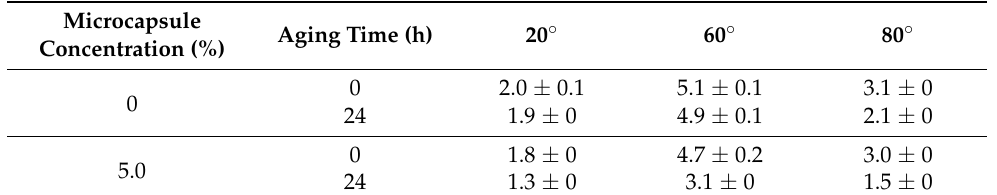
Table 10. Gloss change after UV aging.